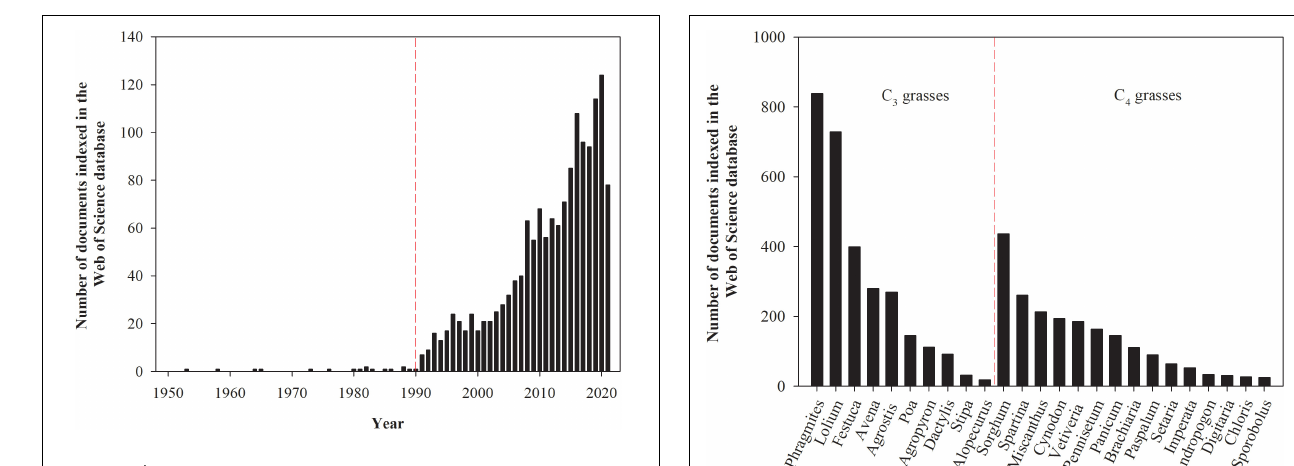
FIGURE 1 | The number of documents indexed in the Web of Science database assessing the ability of grasses to survive in environments polluted by potentially toxic trace elements. The numbers presented in the figure were obtained from the search with the keywords grass and heavy metals on August 4, 2021. These numbers are subjected to changes according to keywords used for search.